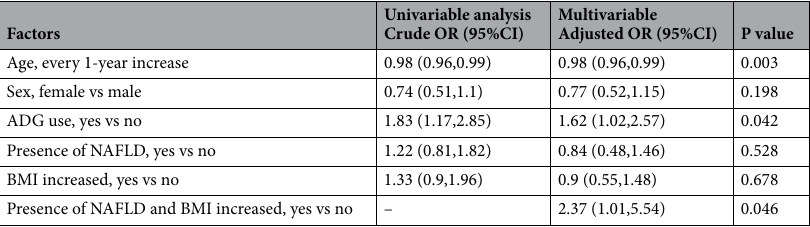
Table 3. Logistic regression analyses of predicting factors associated with an increased ALT (ΔALT > 3 U/L). ADG, andrographolide; ALT, Alanine aminotransferase; BMI, body mass index; NAFLD, non-alcoholic fatty liver disease; OR, odd